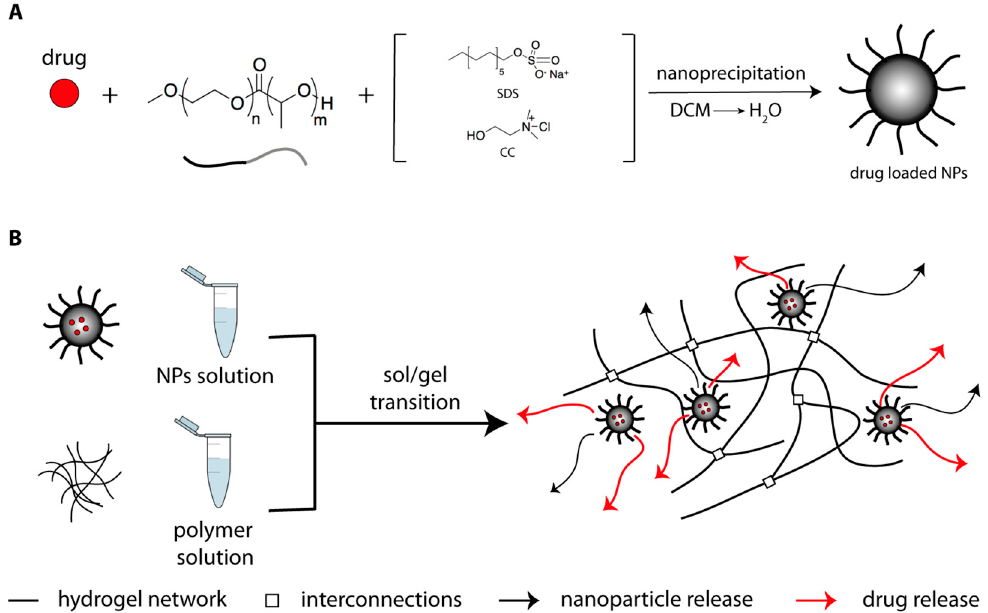
Figure 1. ( A ) Biodegradable core-shell nanoparticles prepared by nano-precipitation of amphiphilic poly(ethylene glycol)-block-poly(lactic acid) (PEG- b -PLA) copolymers, synthesized by organocatalytic ring-opening polymerization, from DCM (a good solvent for both blocks) into H 2 O (a selective solvent for the PEG block). ( B ) Schematic representation of the AC-NPs composite releasing system. Table 1. Characteristics of the produced nanoparticles (NPs) as measured by dynamic light scattering (DLS). Polydispersity index (PDI); sodium dodecyl sulphate (SDS); choline chloride (CC). Diameter (nm)